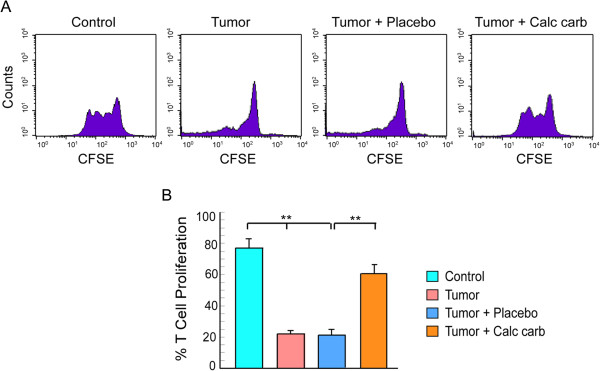
Calcarea carbonica attenuates tumor-induced inhibition of T cell proliferation. Flow cytometric histogram display of CFSE-fluorescence dilution (A) and its graphical representation (B) to determine CD3/CD28-stimulated effector T cell proliferation from untreated and placebo-/calcarea carbonica-treated tumor-bearing mice at 21 days of drug administration. Values are mean ±SEM of five independent experiments. **p < 0.001 when compared with respective non-tumor/tumor-bearing control sets and placebo/drug-treated sets.